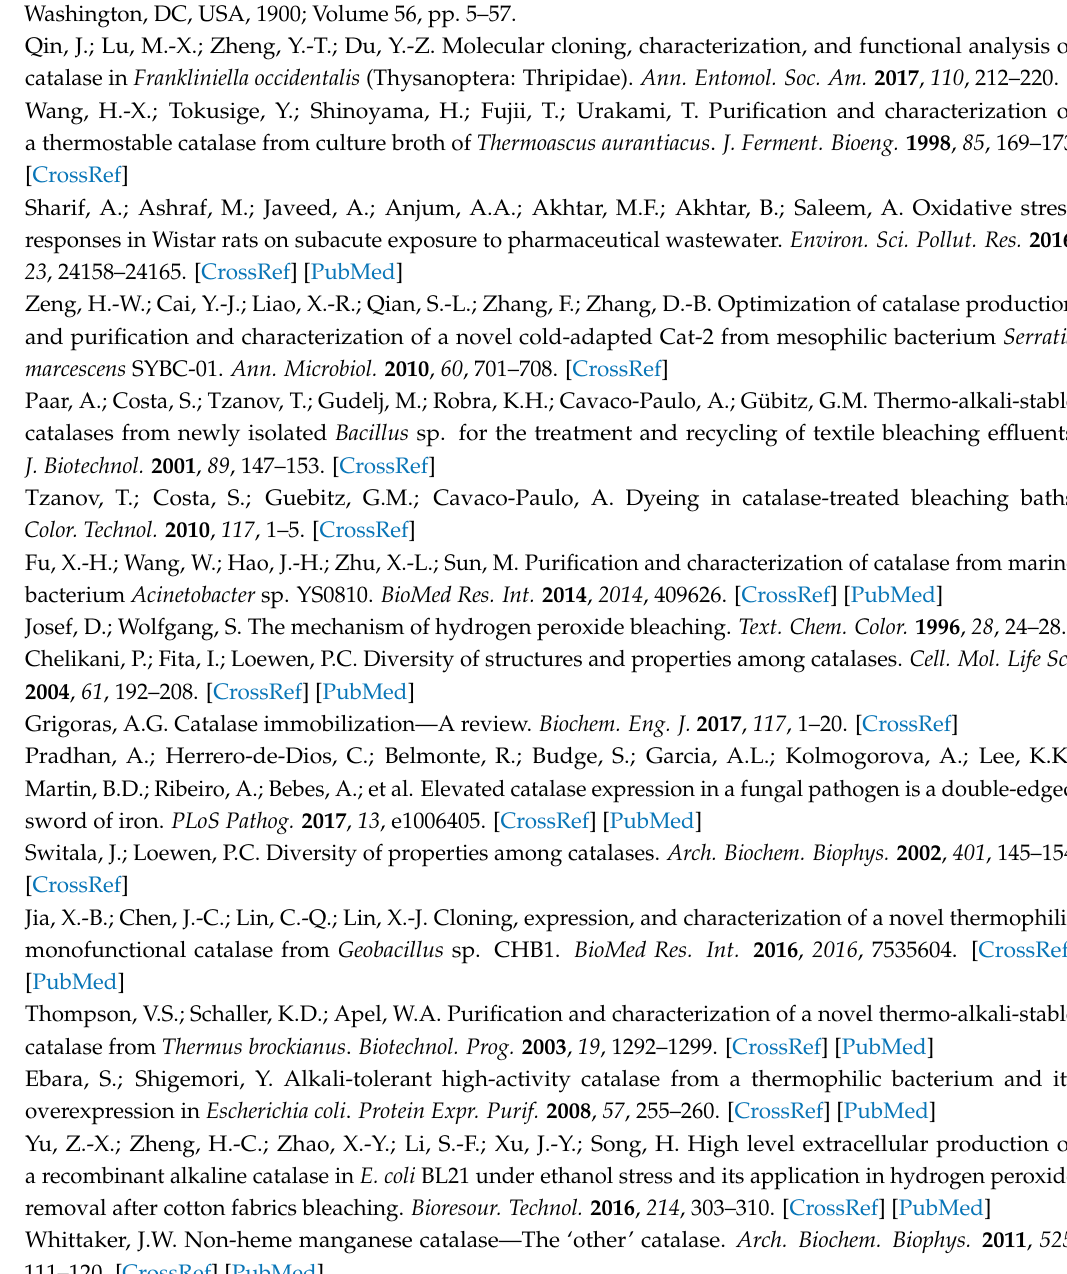
Figure S1: Recombinant plasmid of pET20b-MnCAT map, Figure S2: Coomassie-blue stained SDS-PAGE gel of the enzyme, and Figure S3: Gel filtration analysis of purified